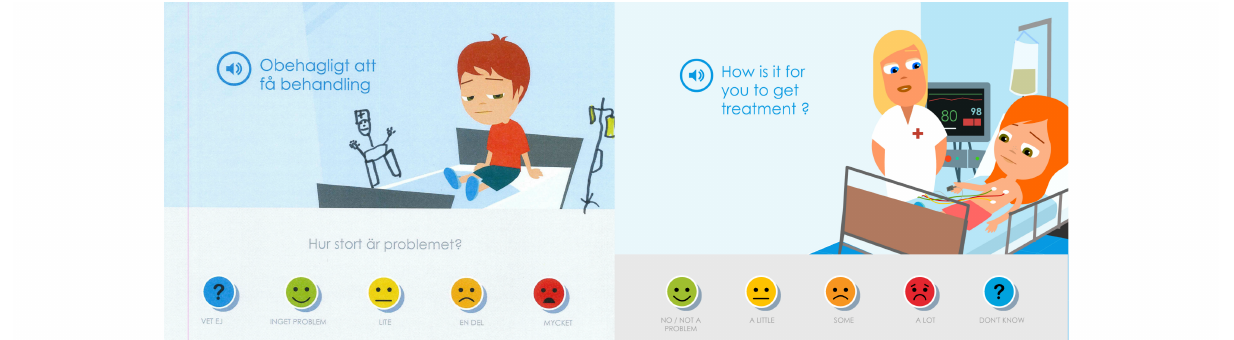
Figure 9. The children suggested that pictures at the hospital should include a nurse or a doctor. Left: an example of what a child drew on a screenshot; Right: the final version in Sisom 2.